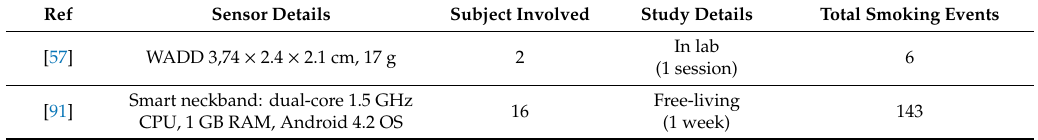
Table 11. A summary of acoustic sensor and validation study involved in smoking